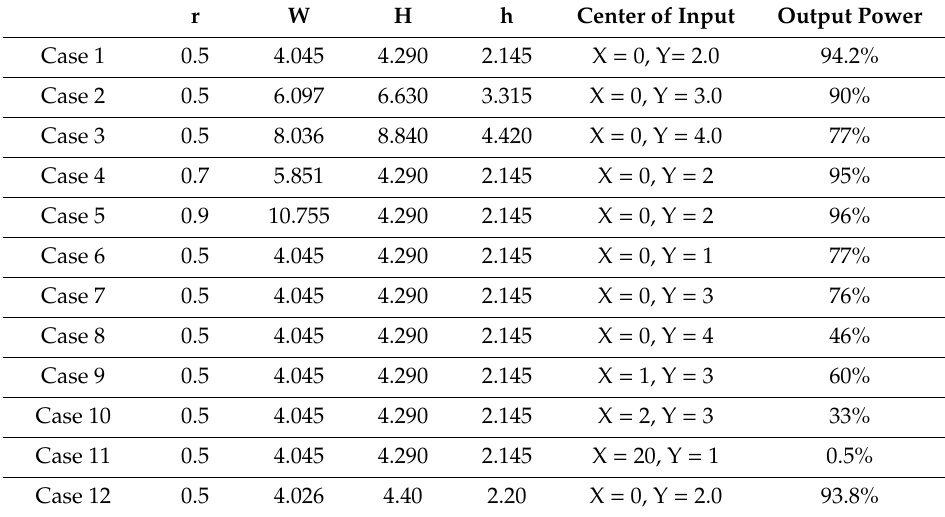
Table 2. Comparison of output power as a function of input beam position and waveguide